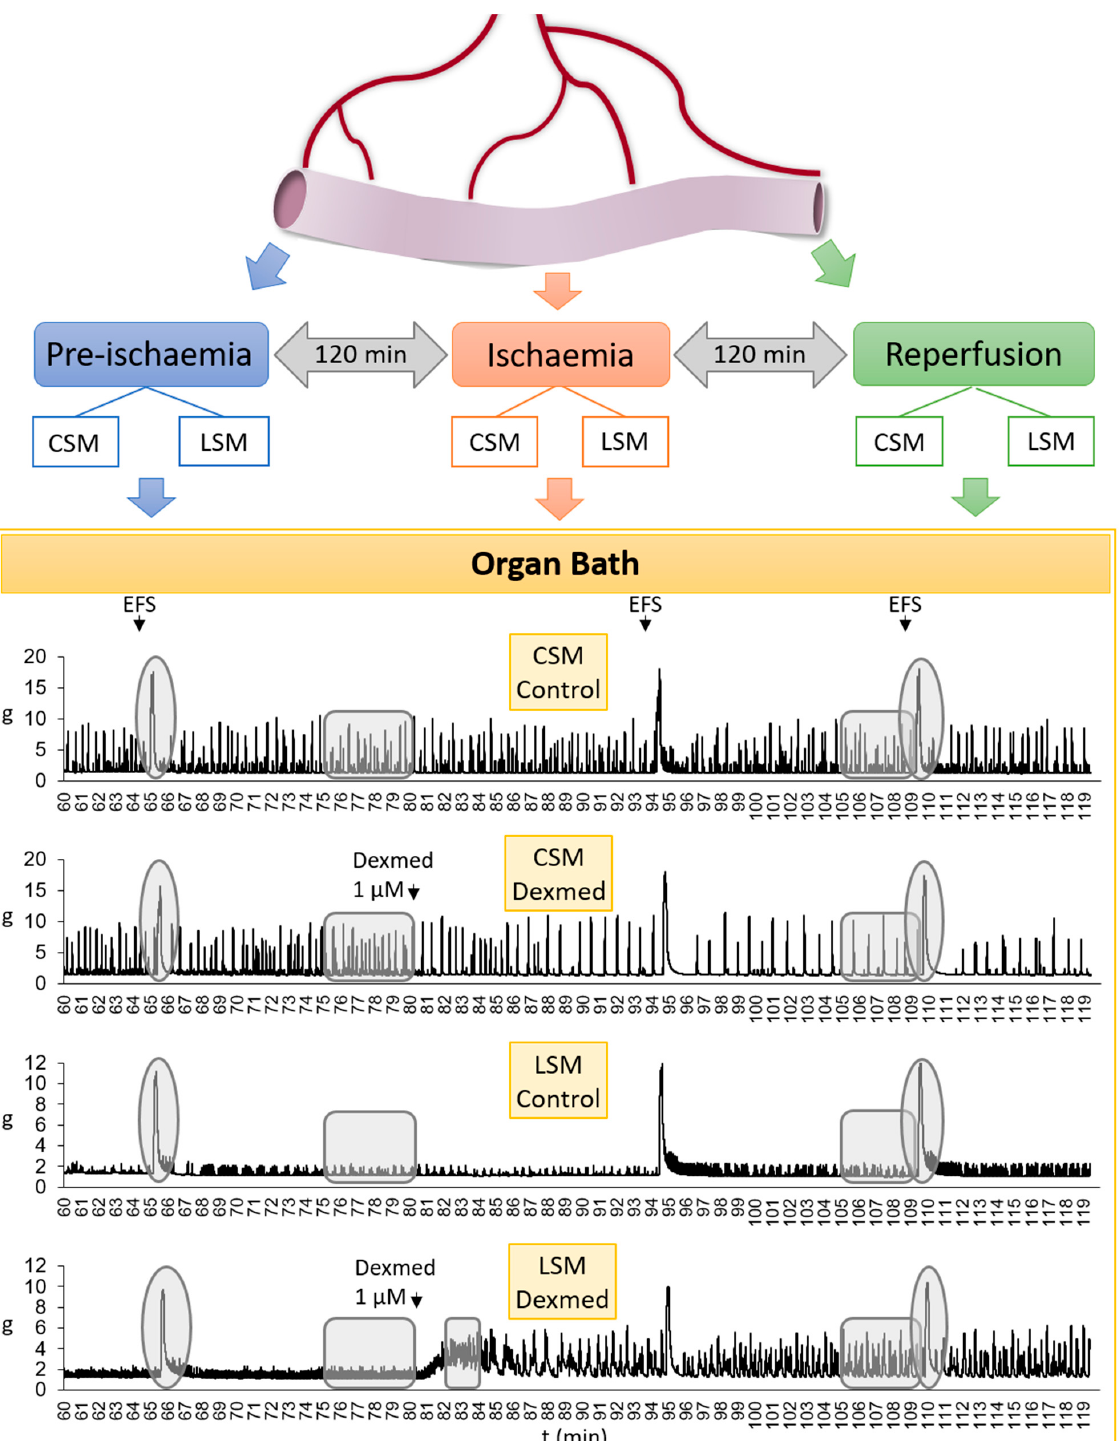
Figure 1. Diagram depicting the timing of the experiment on day 1 including the original traces of representative samples of circular and longitudinally oriented jejunal smooth muscle strips (CSM and LSM, respectively) with and without dexmedetomidine (Dexmed) addition. The oval shaded areas represent the induced contractile activity following electrical field stimulation (EFS) at t65 and t110. The rectangular shaded areas represent the basal contractile activity at t75–80 and t105–110 (additional t~85 for LSM